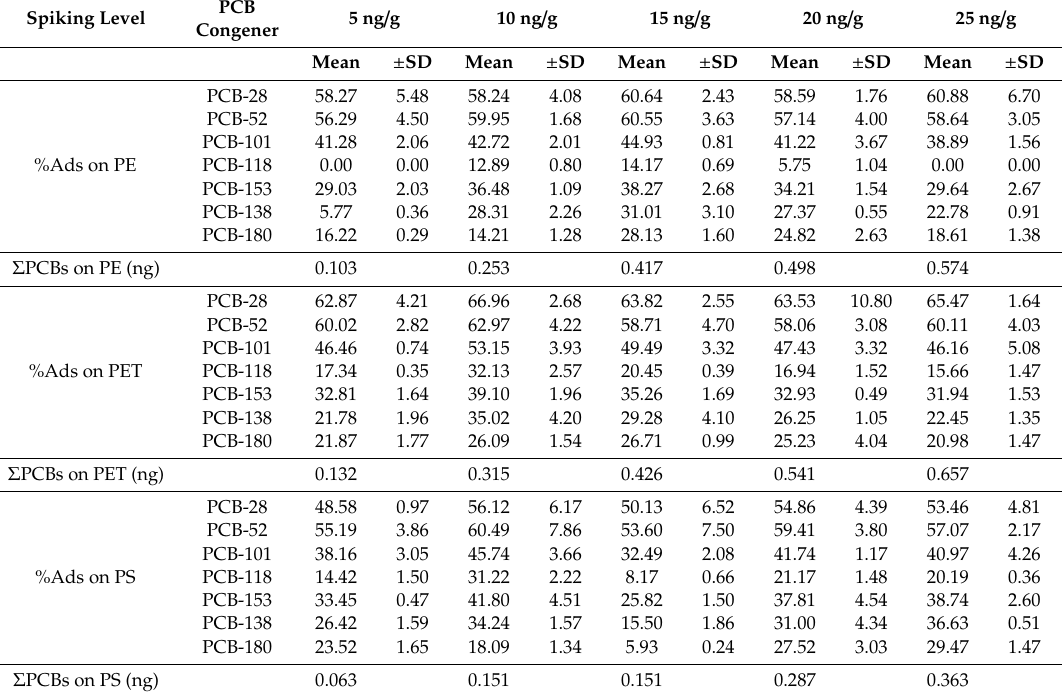
Table 1. Adsorption percentages for PCBs vs. spiked concentration in all polymers and sum of PCBs adsorbed on